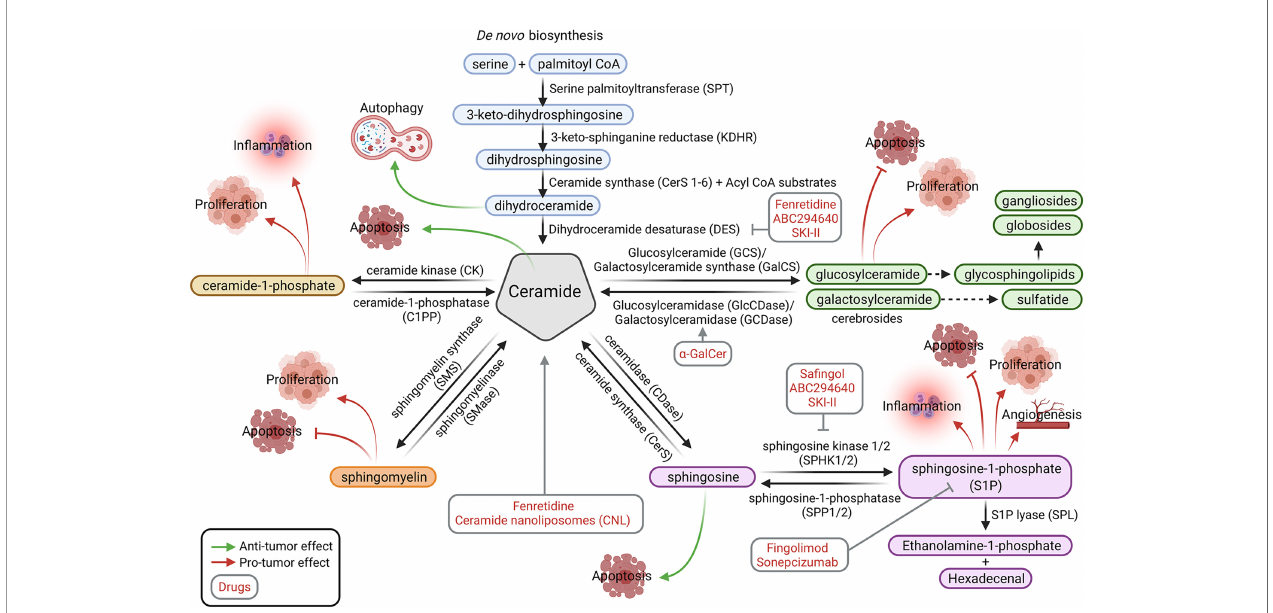
FIGURE 2 | Sphingolipid metabolic pathways. The sphingolipid modulators (in red) and affected tumor processes (processes by which molecules promote tumor growth are indicated with red arrows, whereas those that inhibit tumor growth are indicated with green arrows) are shown. Ceramide is the central molecule that is synthesized through the de novo pathway or other catabolic pathways through conversion from ceramide-1-phosphate, sphingomyelin, sphingosine, glycosphingoplidis, or sulfatides (glucosyl or galactosyl-ceramide). Figure created with BioRender.com.